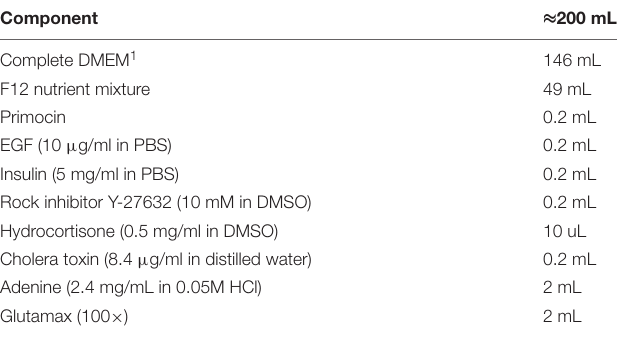
TABLE 1 | Formulation of complete F